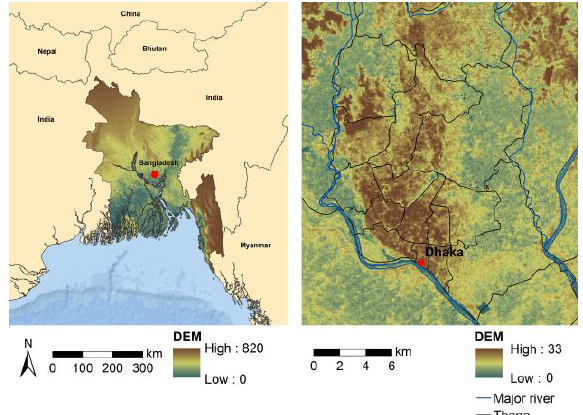
Figure 1. The study area (Dhaka,